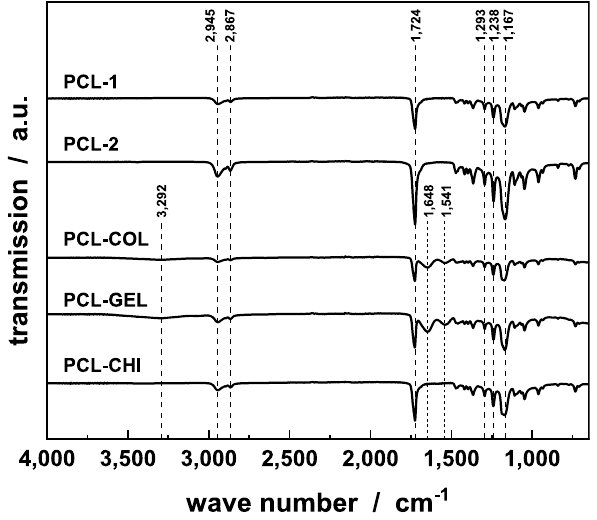
Figure 2. FT-IR spectra of all samples. Significant peaks for collagen and gelatine are shown, indicating a successful integration of the blend components in the PCL matrix. For the chitosan-blended nanofibers, the typical peak at 3.292 cm −1 is very weak due to the low content of chitosan in the initial spinning